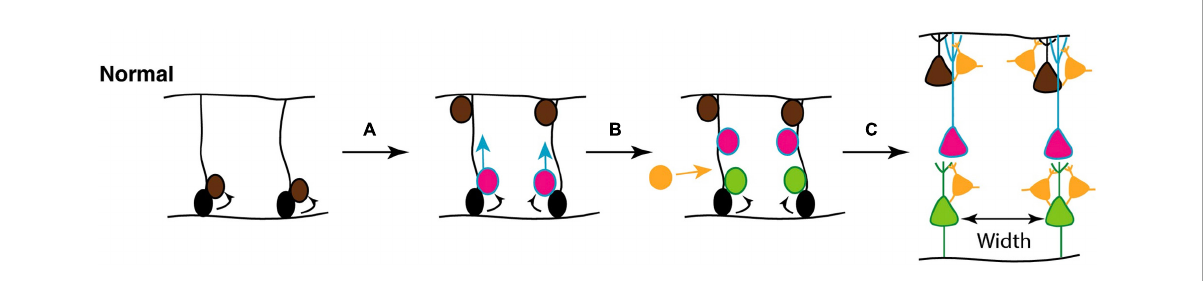
FIGURE8 (A) Mechanisms underlying focal organization and minicolumn distribution in the cortex. During normal cortical development, radial glial neural stem and progenitor cells (NSCs; black) located in the ventricular zone, with radial processes extending to the pial surface of the neural epithelium, can undergo symmetrical divisions to produce more radial glial NSCs (brown) or asymmetric divisions (A) to maintain the NSC pool and generate committed neural progenitors (pink); (B) the latter migrate toward the pial surface on the radial scaffold, where they differentiate into projection neurons. This process continues with different classes of neurons (pink, green) being produced in successive waves over developmental time. Hence, different neuronal types are grouped together in different cortical layers (C) . GABAergic interneurons (orange) migrate into the neuroepithelium (B) , and integrate into the circuitry (C) . At the end of this process, projection neurons are organized in radial minicolumns. Figure adapted from Donovan and Basson (2017), obtained by Elsevier (No. 5410821023270) under a creative commons